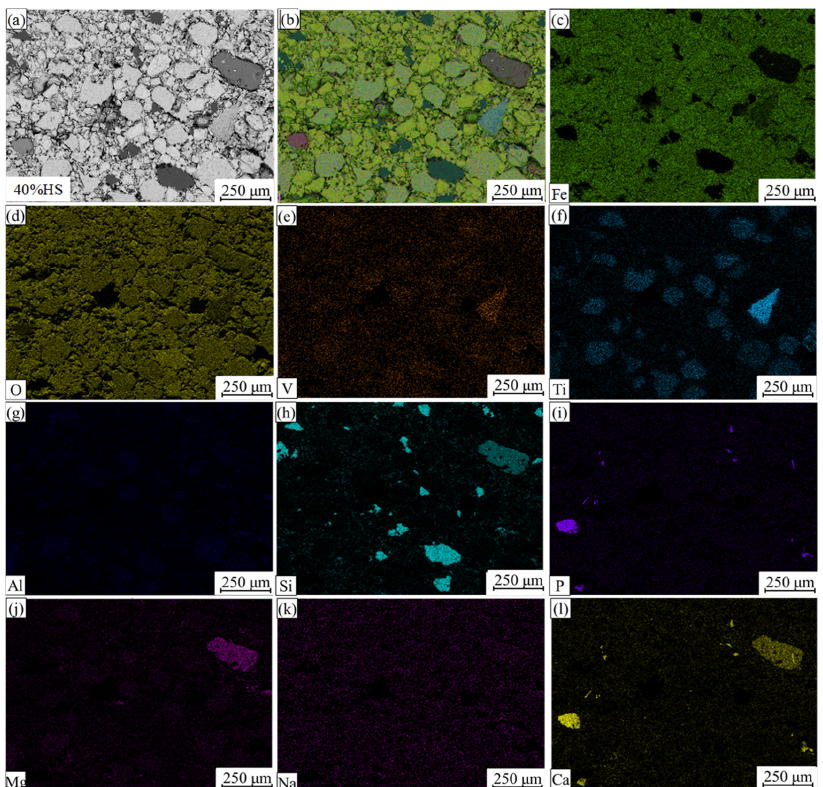
Figure 9. Element distributions of oxidized pellets with 40% sea sand ore. ( a ) Electronic image; ( b ) Layered image;( c ) Fe; ( d ) O; ( e ) V; ( f ) Ti; ( j ) Al; ( h ) Si; ( i ) P; ( j ) Mg; ( k ) Na; ( l ) Ca